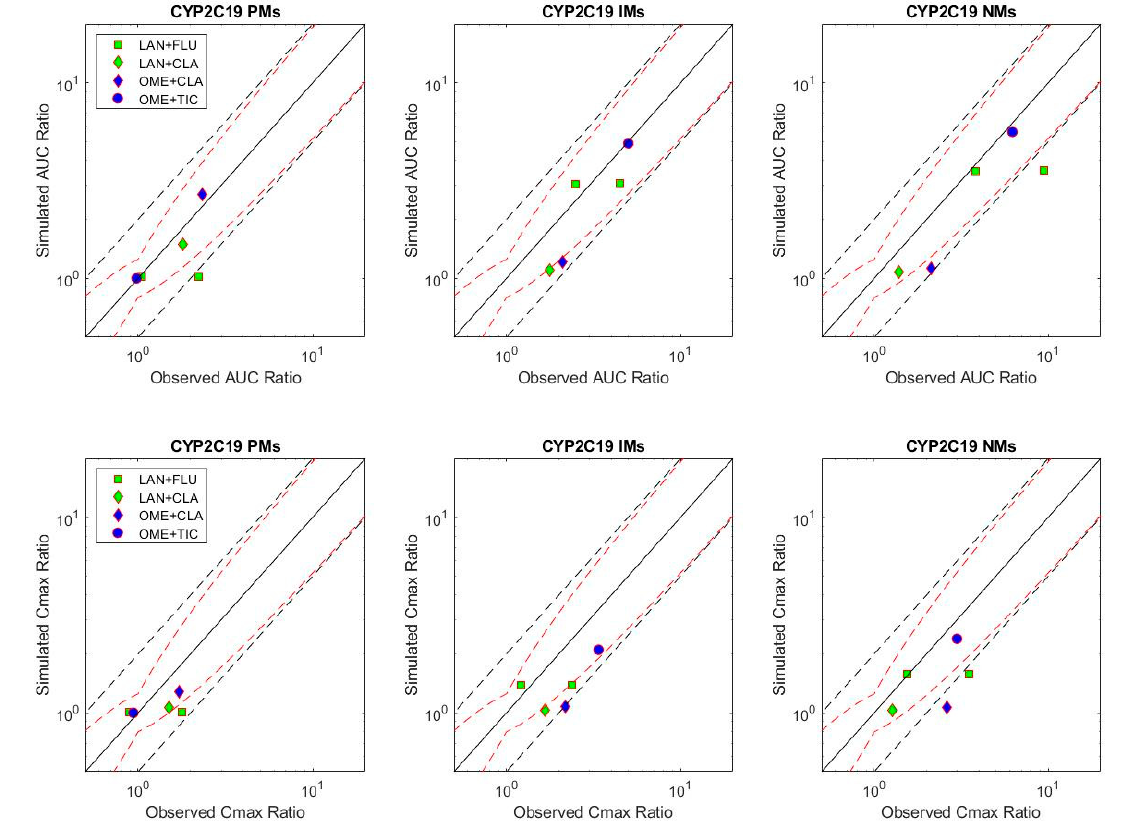
Figure 2. Simulated versus observed mean AUC and C max ratios across CYP2C19 phenotypes for omeprazole and lansoprazole. CLA = clarithromycin; FLU = fluvoxamine; LAN = lansoprazole; OME = omeprazole; TIC = ticlopidine. The solid black line is the line of unity, black dashed lines indicate 2-fold upper and lower acceptance criteria and red dashed lines indicate acceptance criteria suggested by Guest et al. [58].